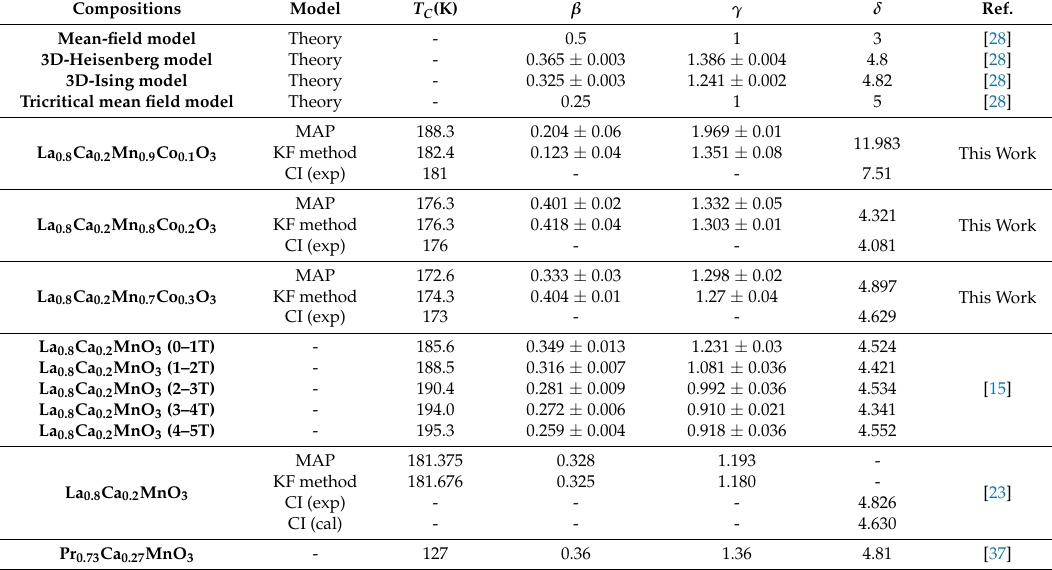
Figure 8. The inverse initial susceptibility χ 0 − 1 (T) as a function of temperature, along with fits (solid curves) based on the power laws (left-axis) defined by (3) and Kouvel-Fisher (right-axis) defined by Equation (6), respectively. For La 0.8 Ca 0.2 Mn 1 − x Co x O 3 , ( a ) x = 0.1, ( b ) x = 0.2, ( c ) x = 0.3. Table 1. Comparison of critical exponents for La 0.8 Ca 0.2 Mn 1 − x Co x O 3 compounds with earlier reports, Abbreviations: MAP, modified Arrott plot; KF, Kouvel-Fisher method; CI, critical Isotherm; exp, experimental; cal, calculated.